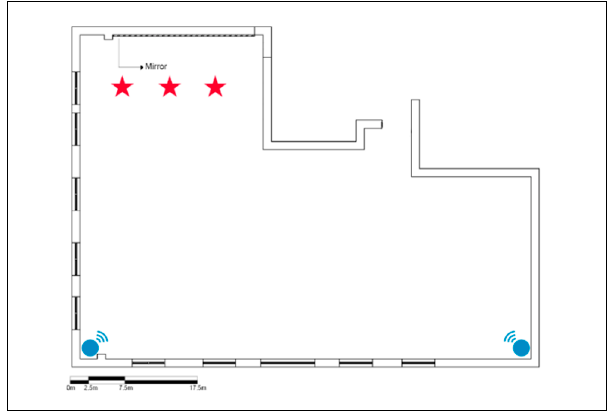
Figure 2. Layout of the measurement set-up in the fitness gym (P); red stars represent the location of measurement points of activity noise level (L A,eq ) and blue points represent the locations of the gymnasium’s loudspeakers.